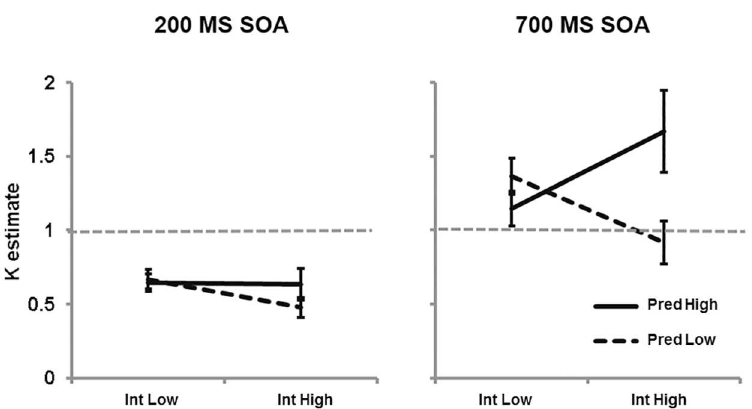
Fig 5. Graph to show estimates of audio-visual integration capacity ( K ) as a function of SOA, interference and temporal predictability. Error bars depict